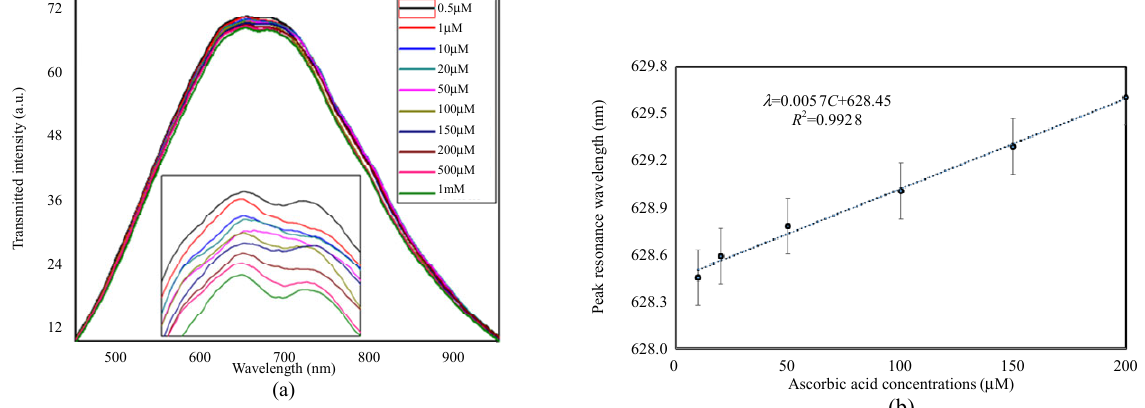
Fig. 13 LSPR sensing of Probe II: (a) transmitted intensity spectra and (b) linearity response of the